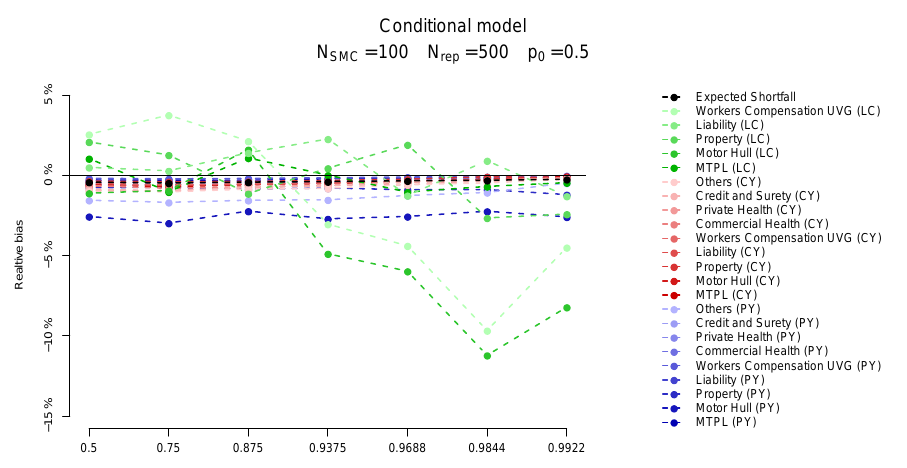
Figure 10. Bias for the conditional model. Note that although the bias for some of the current year (CY) large claims is around 10% their allocated capital is rather small, as seen in Figure 11